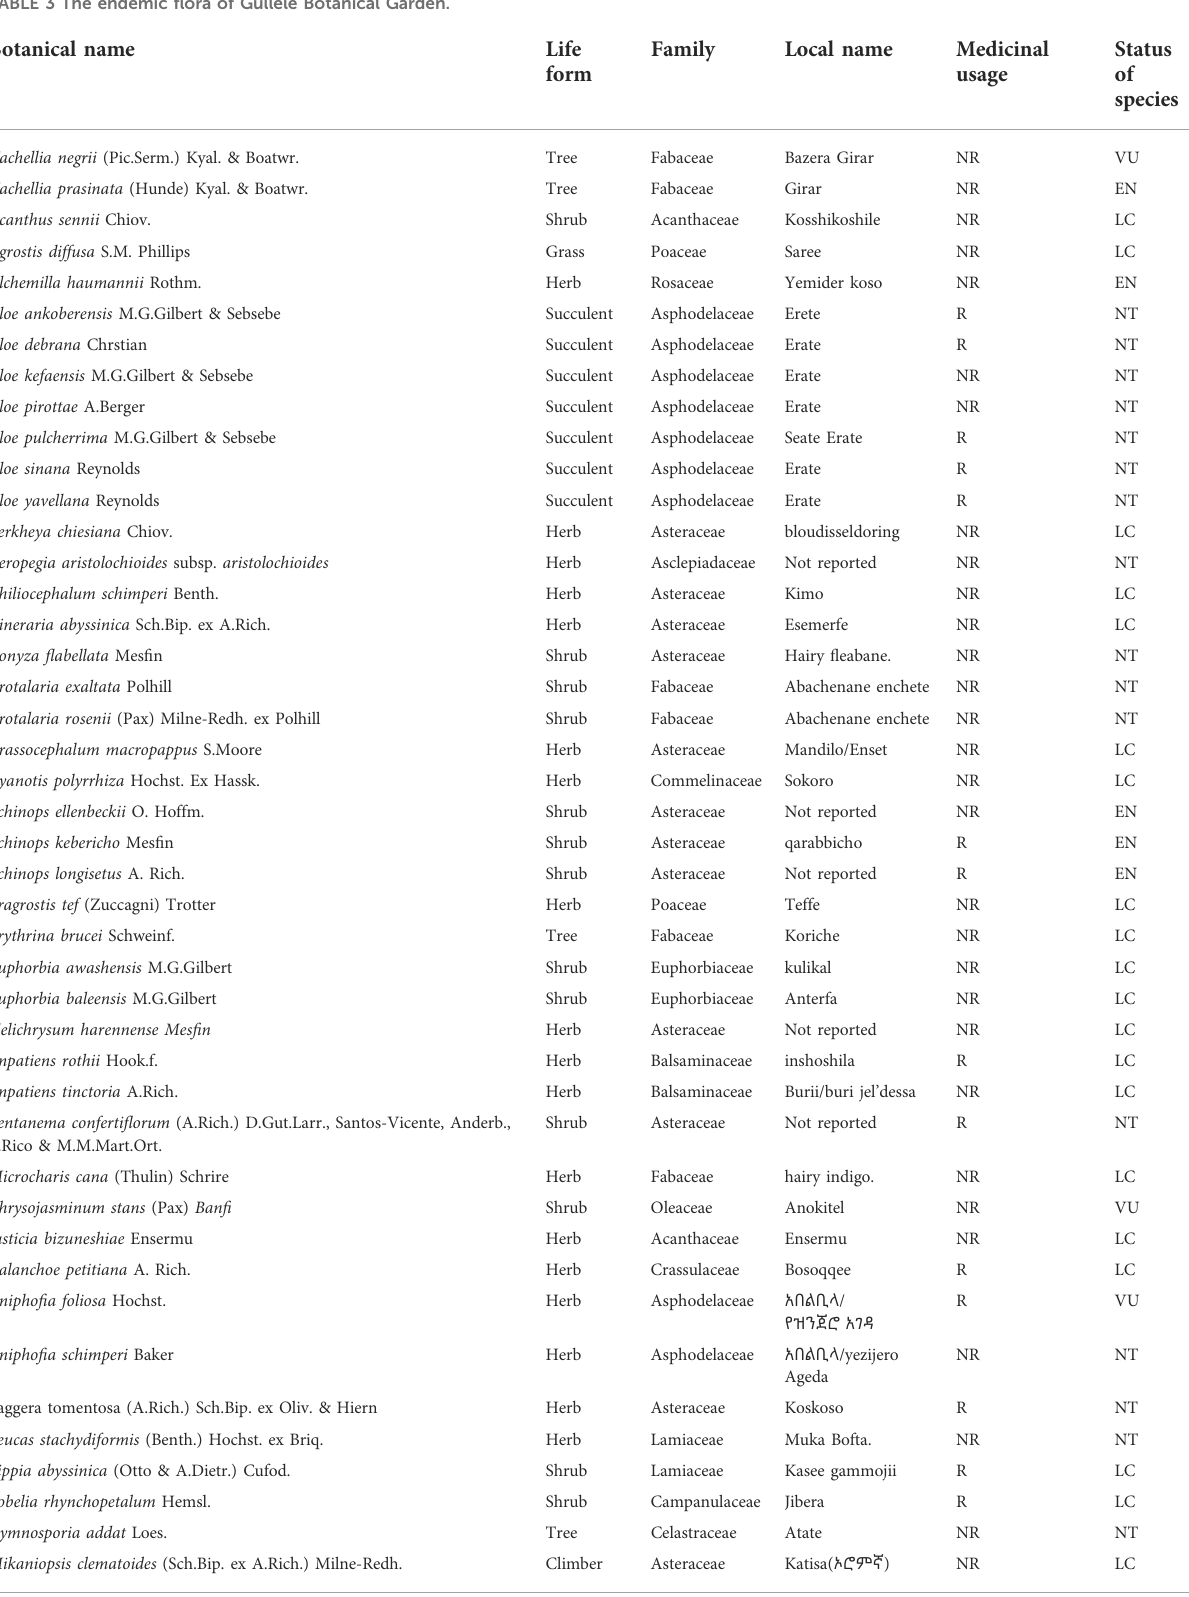
TABLE 3 The endemic fl ora of Gullele Botanical Garden. Botanical